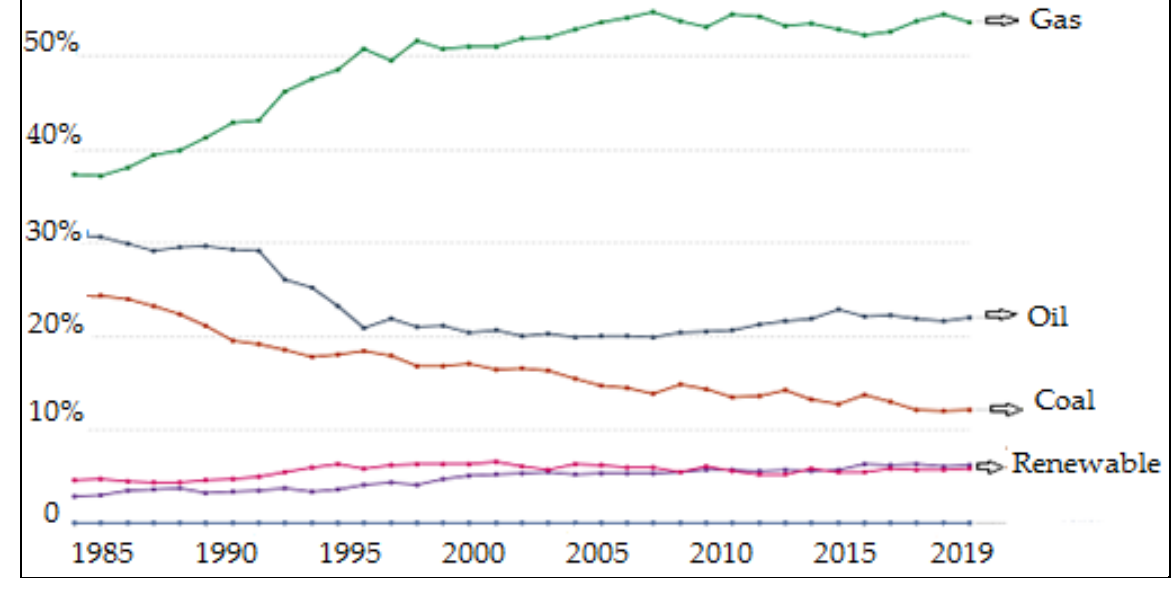
Figure 3. Share of energy consumption by source (quad Btu). Source: [35].